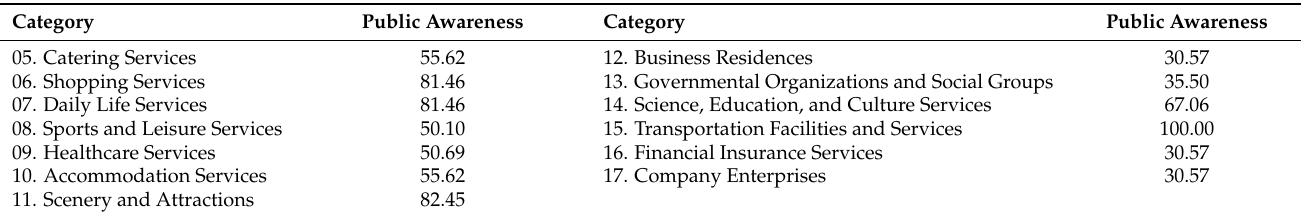
Table 4. The public awareness of